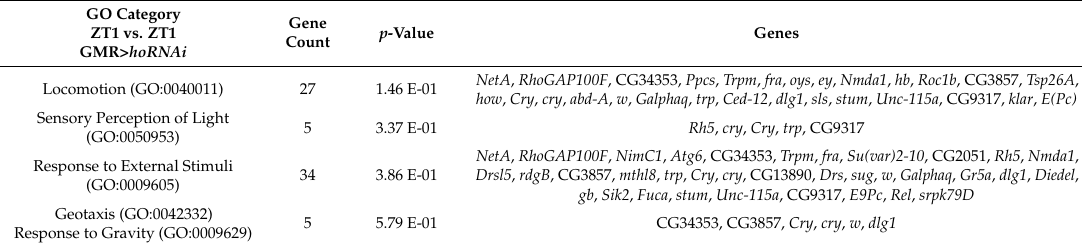
Table 3. List of the most changed Gene Ontology (GO) categories after ho silencing in the retina at ZT1. GO Category ZT1 vs. ZT1